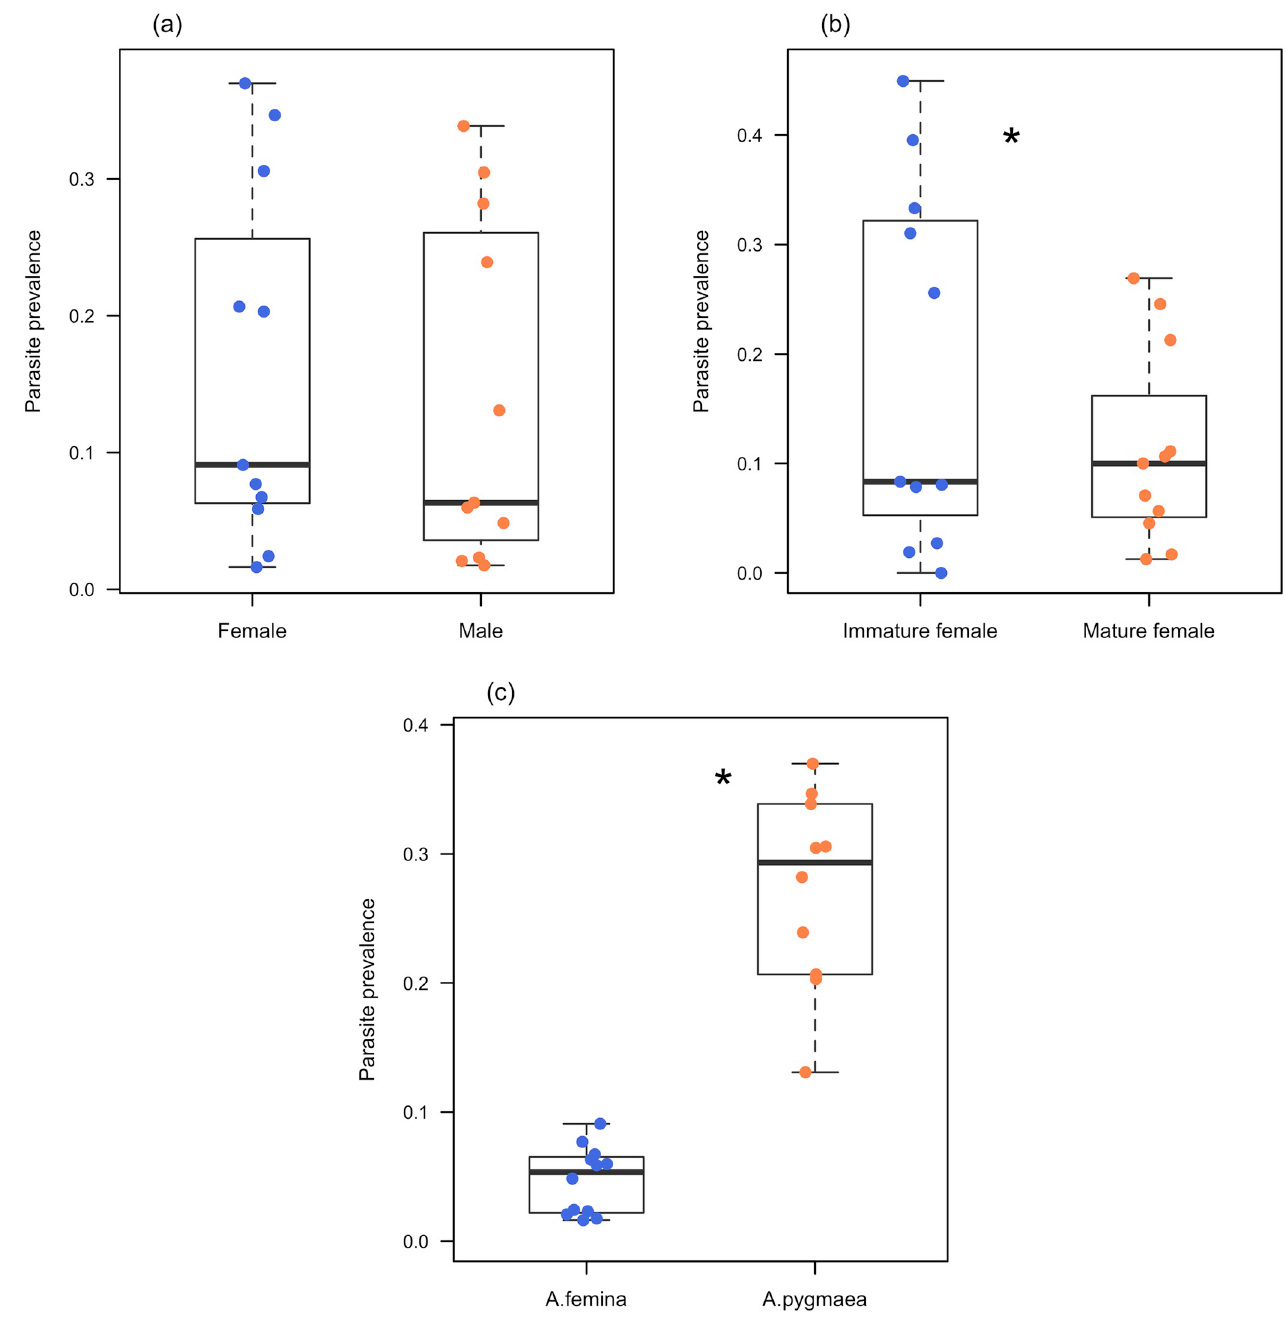
Fig 3. Parasite prevalence in females, males, immature and mature females of Agriocnemis femina and Agriocnemis pygmaea respectively. (a) Parasite prevalence in females and males. (b) Parasite prevalence in immature and mature females (c) Parasite prevalence in Agriocnemis femina and Agriocnemis pygmaea . The bold lines within boxes depict the median. The bottom and top borders of the boxes indicate 25th and 75th percentiles, respectively. The whiskers include all data points excluding the data that are beyond 1.5 times the interquartile range. Circle indicates parasite prevalence at each study site. � denotes p <